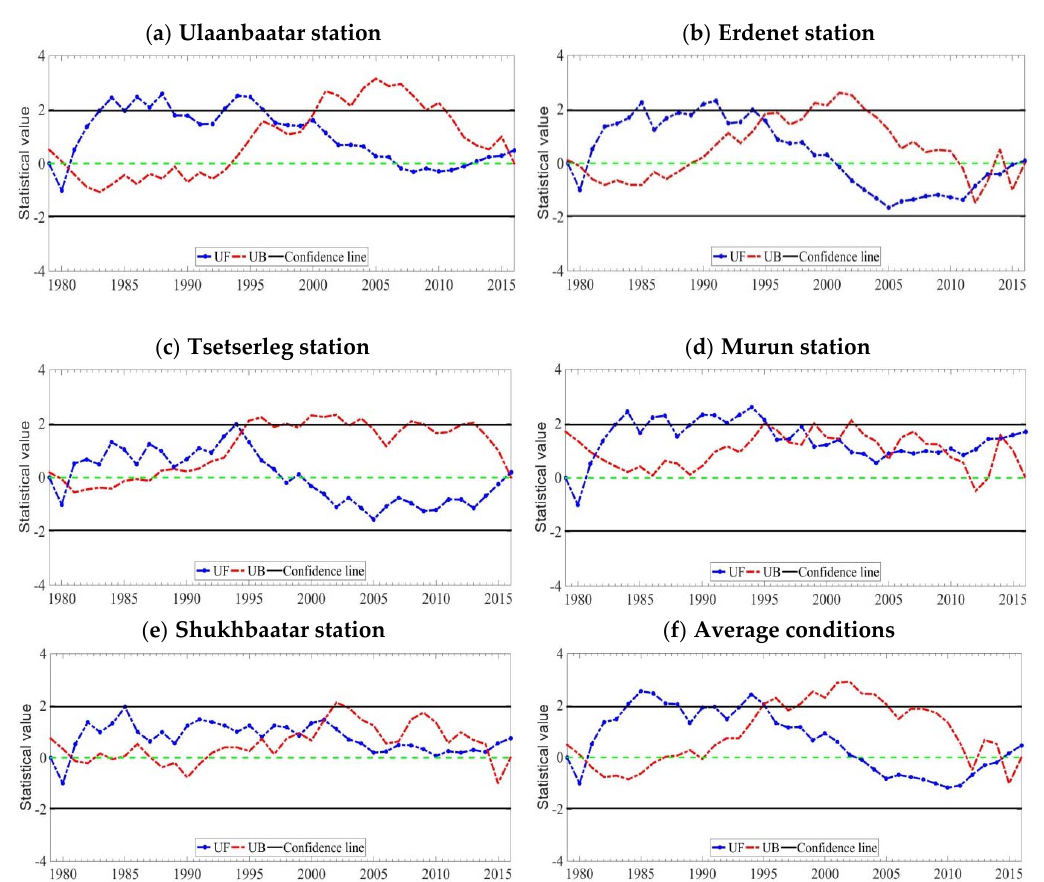
Note: The number in the brackets indicates low precipitation rates.